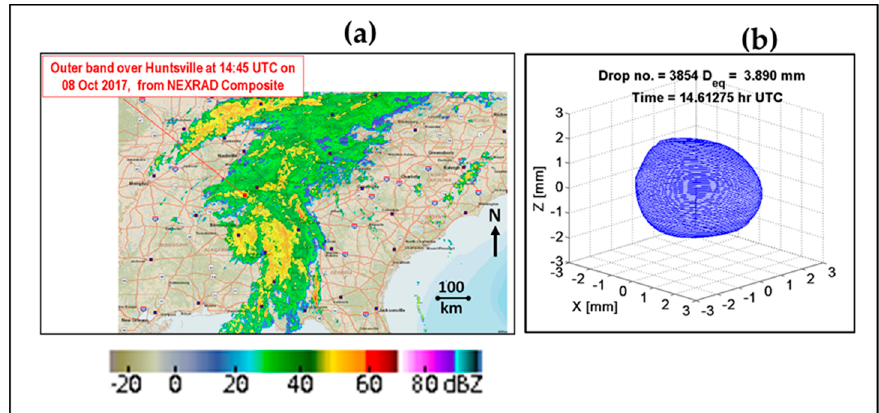
Figure 1. ( a ) Composite next generation radar (NEXRAD) radar image of reflectivity during Tropical Depression Nate over Alabama on 08 October 2017 at 14:45 UTC. The location of the 2D-video disdrometer (2DVD) and other instruments is marked with a red dot; ( b ) shape of a large drop recorded by the 2DVD at this time (using the 3D reconstruction procedure, see Section 3).